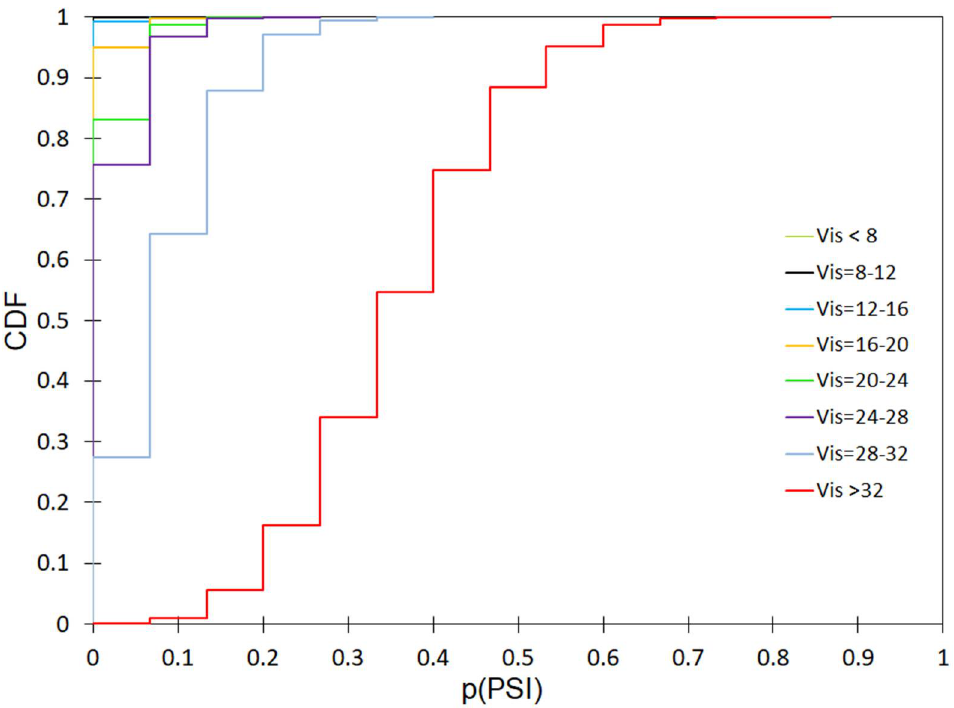
Figure A18. Effect of visibility on the incidence of mean summer mortality for dry days.